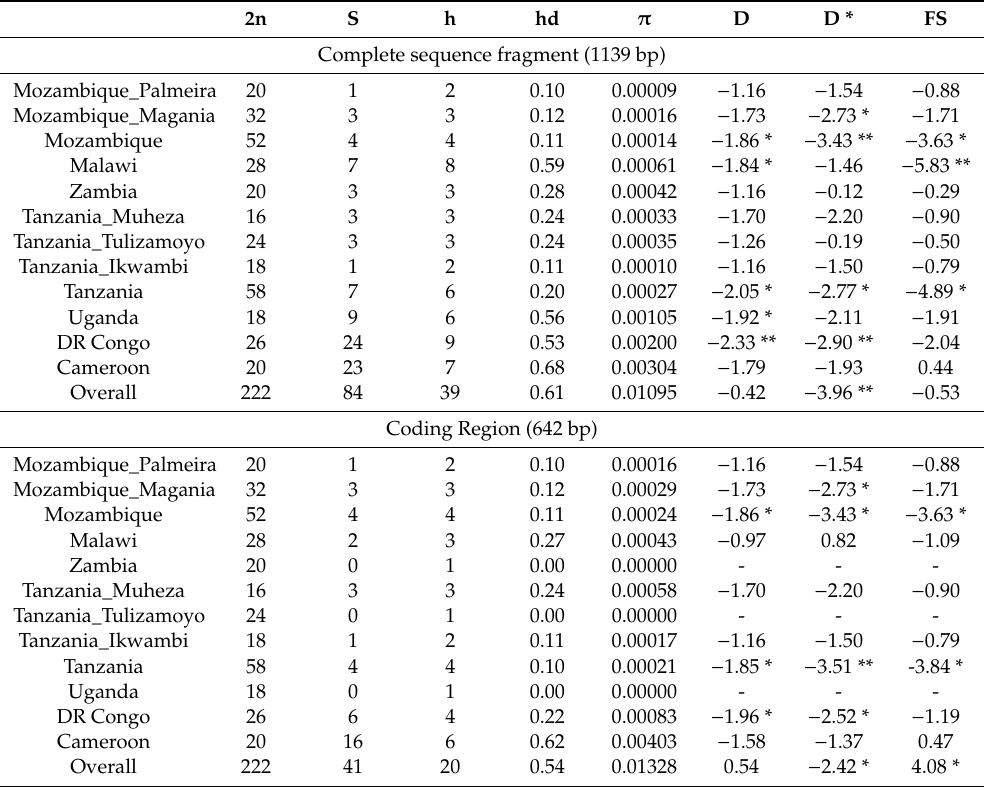
Table 1. Nucleotide diversity and neutral test at